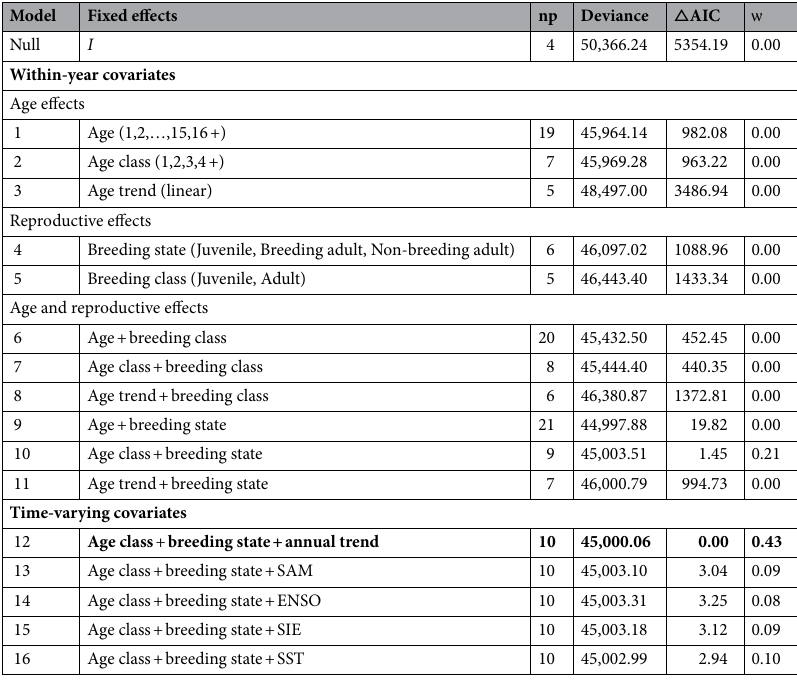
Table 1. Model selection of the variation in the moult arrival dates of female southern elephant seals over 32 years (1986–2018) at Marion Island. Year and individual identity were included as random effects in all models. The most parsimonious model is in bold. np is the number of estimated parameters, △ AIC is the difference between a current model and the model with the lowest AIC value and the Akaike weight ( ѡ ) represents the relative support for a model given the data and the other models in the selection set. The environmental covariates are Southern Annular Mode (SAM), El Niño Southern Oscillation (ENSO), Sea Ice Extent (SIE) and Sea Surface Temperature